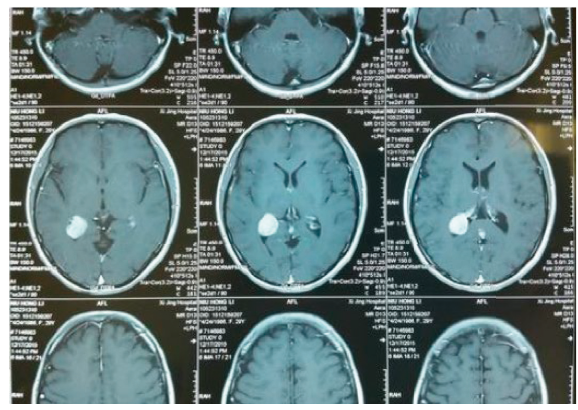
Figure 4: Brain MRI image data. Table 5: Image grading statistics.